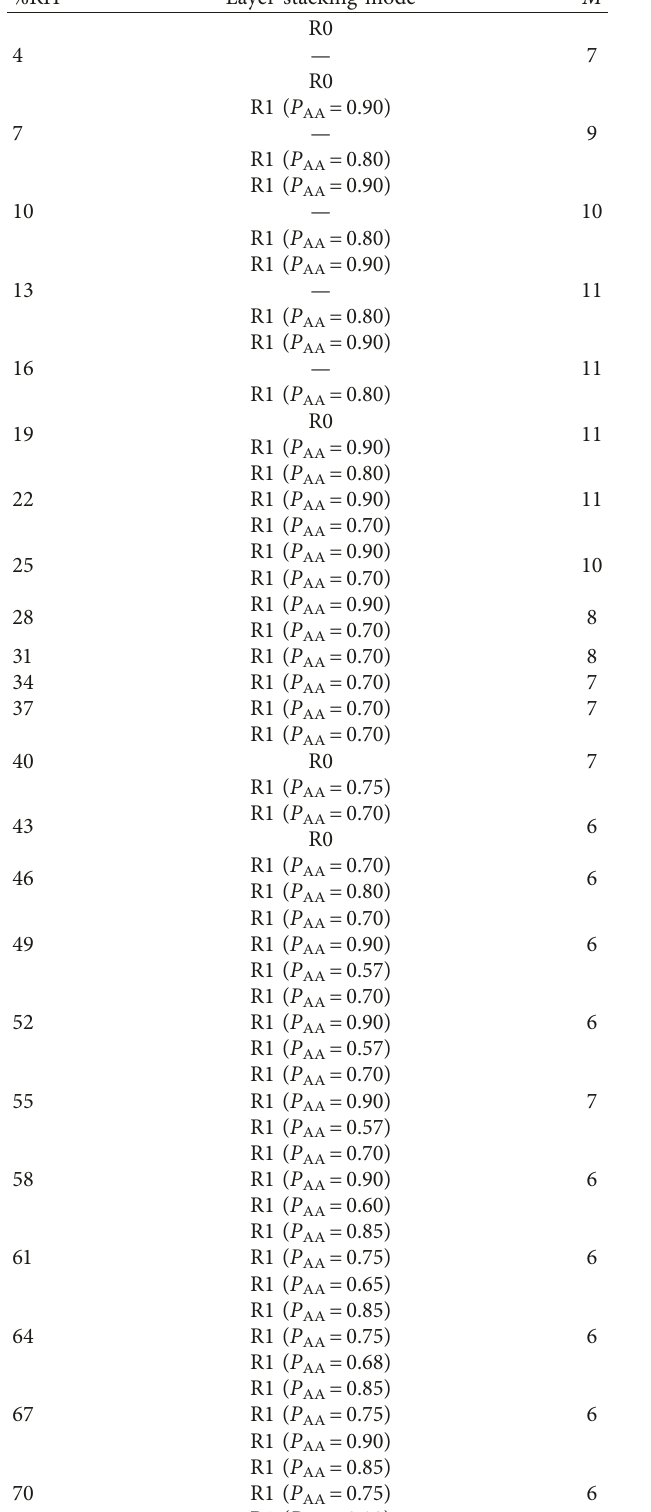
Table 3: Some structural parameters obtained from the quanti- tative XRD analysis in the case of the stressed sample along the sorption